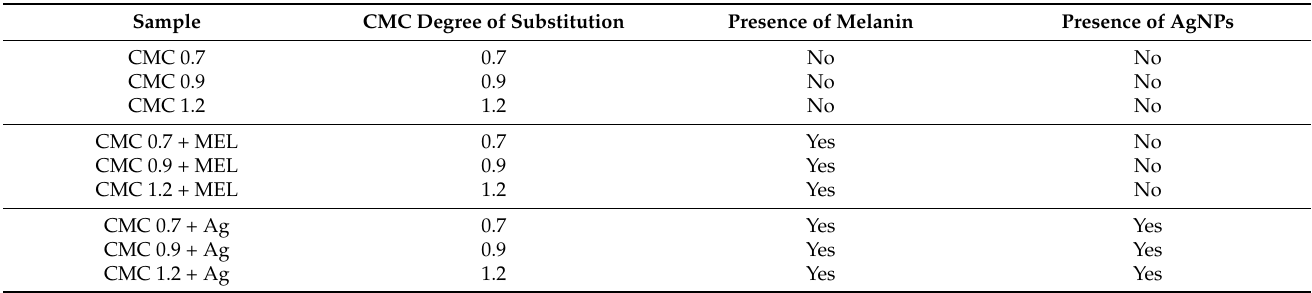
Table 4. Summary of films